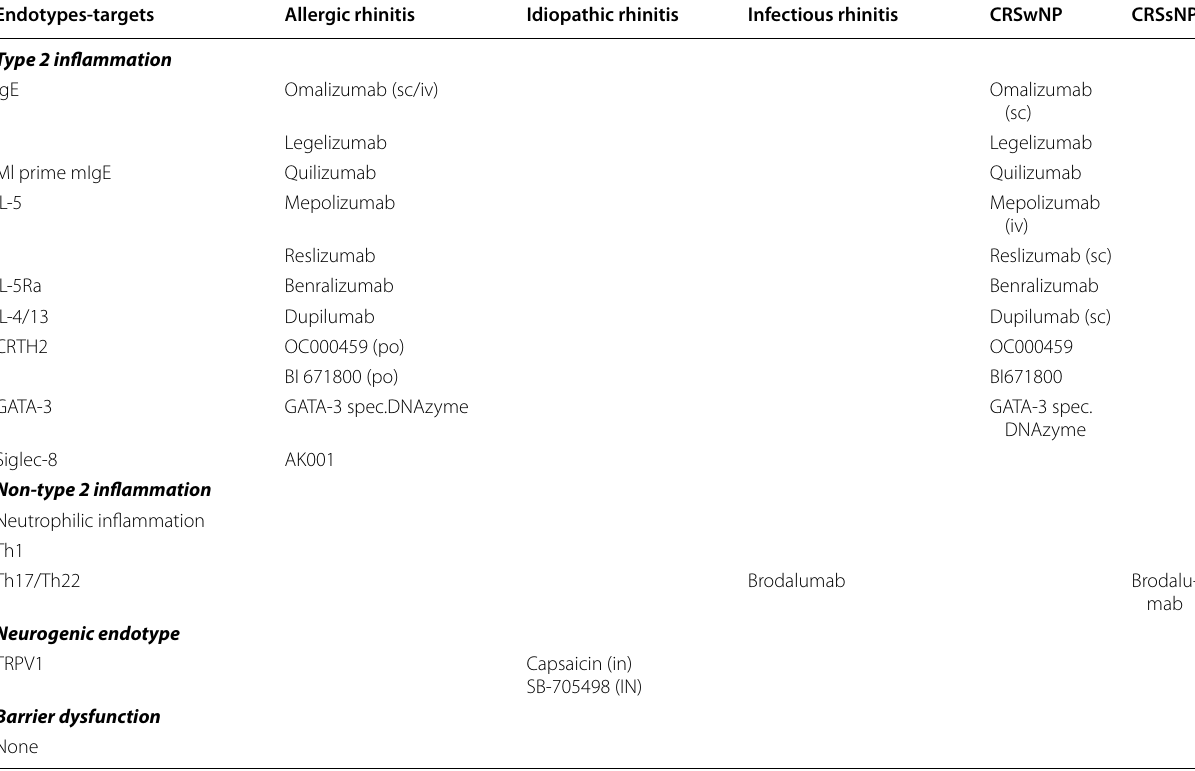
IN intranasal; IV intravenous; po per os; sc